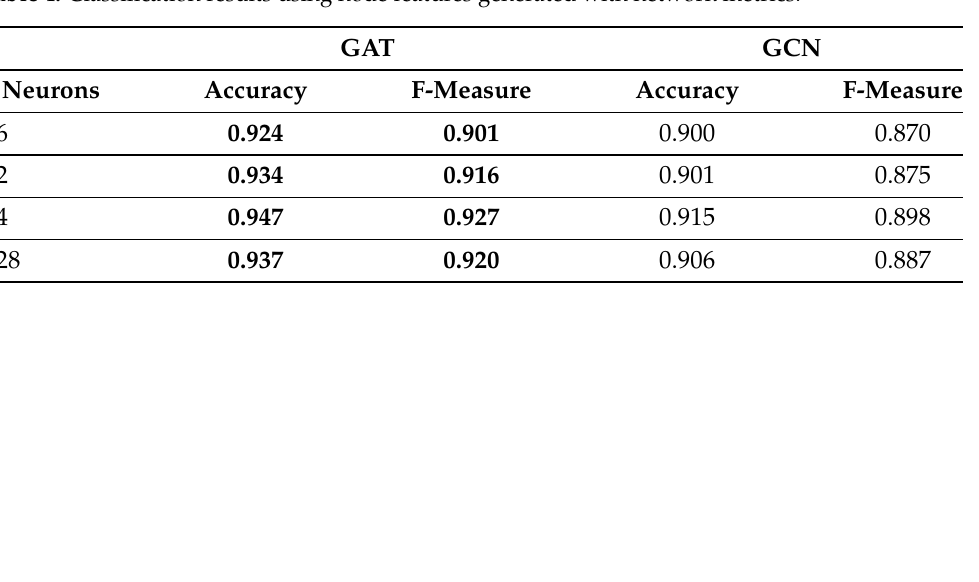
Table 4. Classification results using node features generated with network